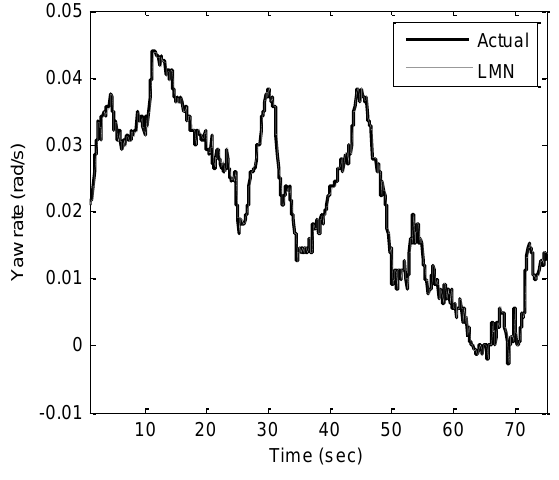
Figure 10. Yaw rate estimation.